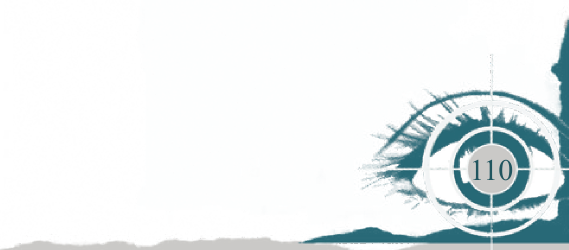
Figure 1 The effect of magnification  vectors. o is the origin; it is unaffected by the magnification. x is magnified to y by X changes the length and rotates most vectors. However x is doubled in length but is not rotated and x and its direction is reversed. x the corresponding eigenvalues are 2 and 2 −